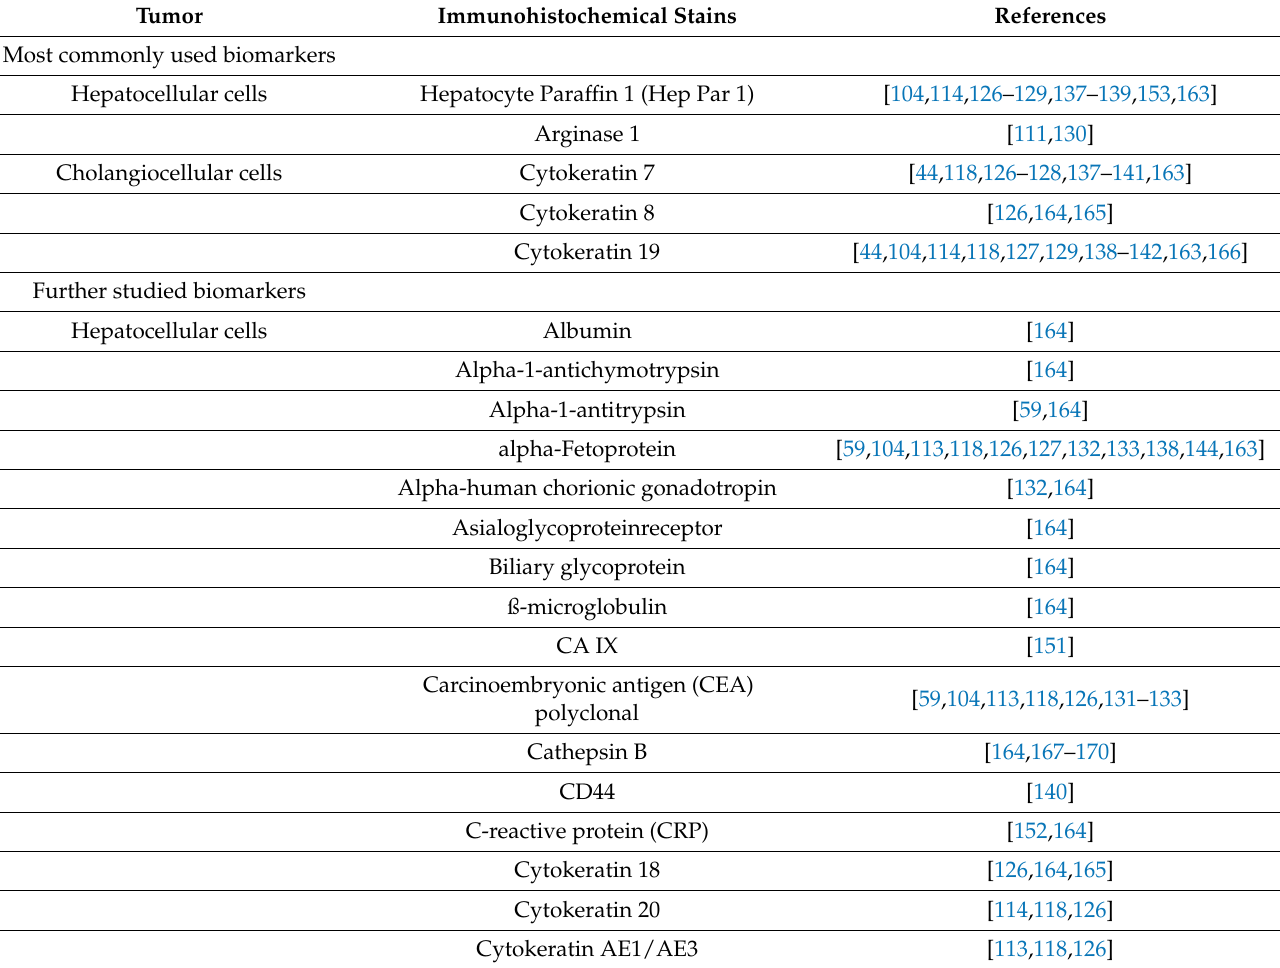
Table 2. Summarization of some antigens demonstrable in tumor cells of cHCC-CCA 1 .